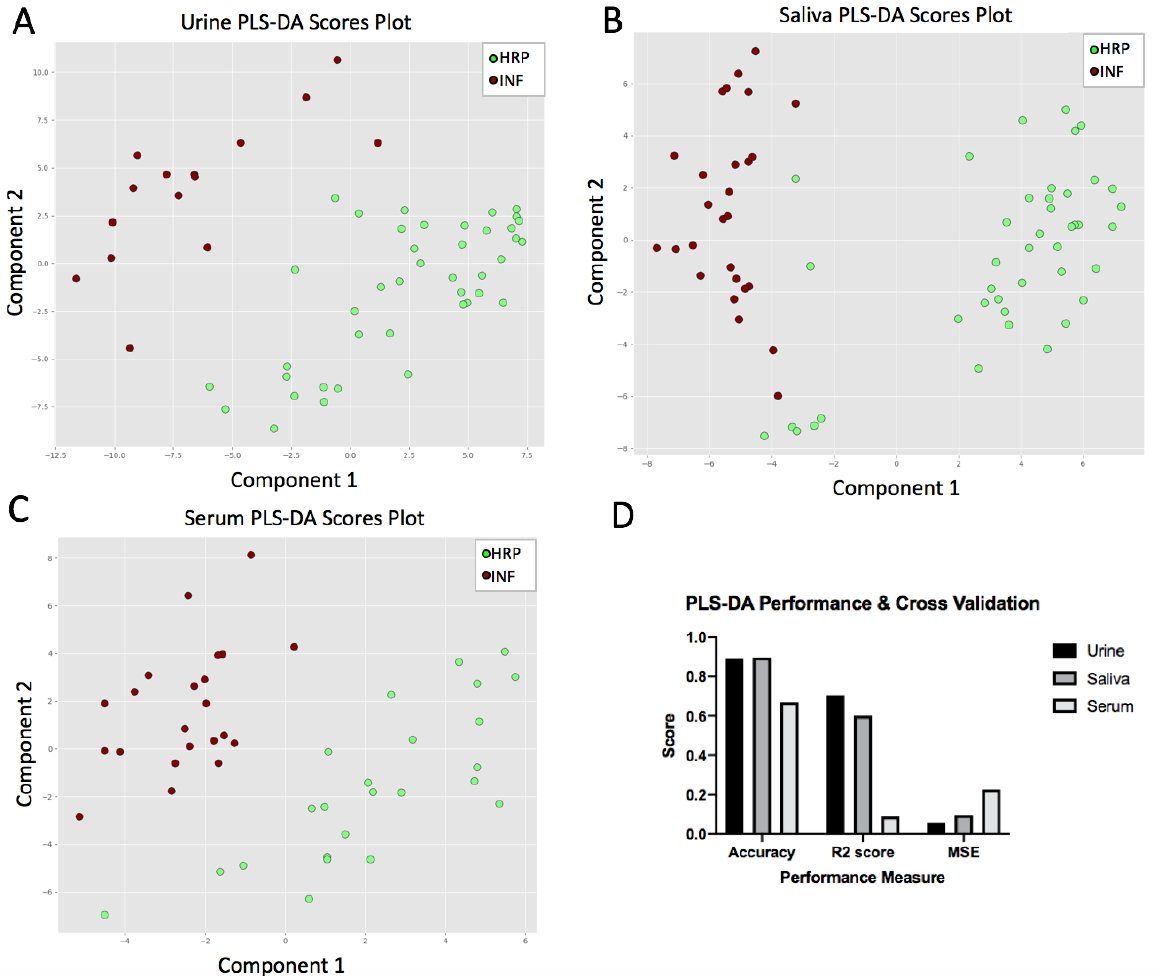
Figure 2. Distinct metabolic separation between HRP and INF pigs based on concentration of analyzed metabolites. PLS-DA plots clearly separated the HRP and INF groups using metabolite concentrations evaluated in urine ( A ), saliva ( B ), and serum ( C ). Cross validation and performance measures ( D ) of the PLS-DA models suggest that urine and saliva perform better than serum in the metabolic separation of the HRP and INF groups.